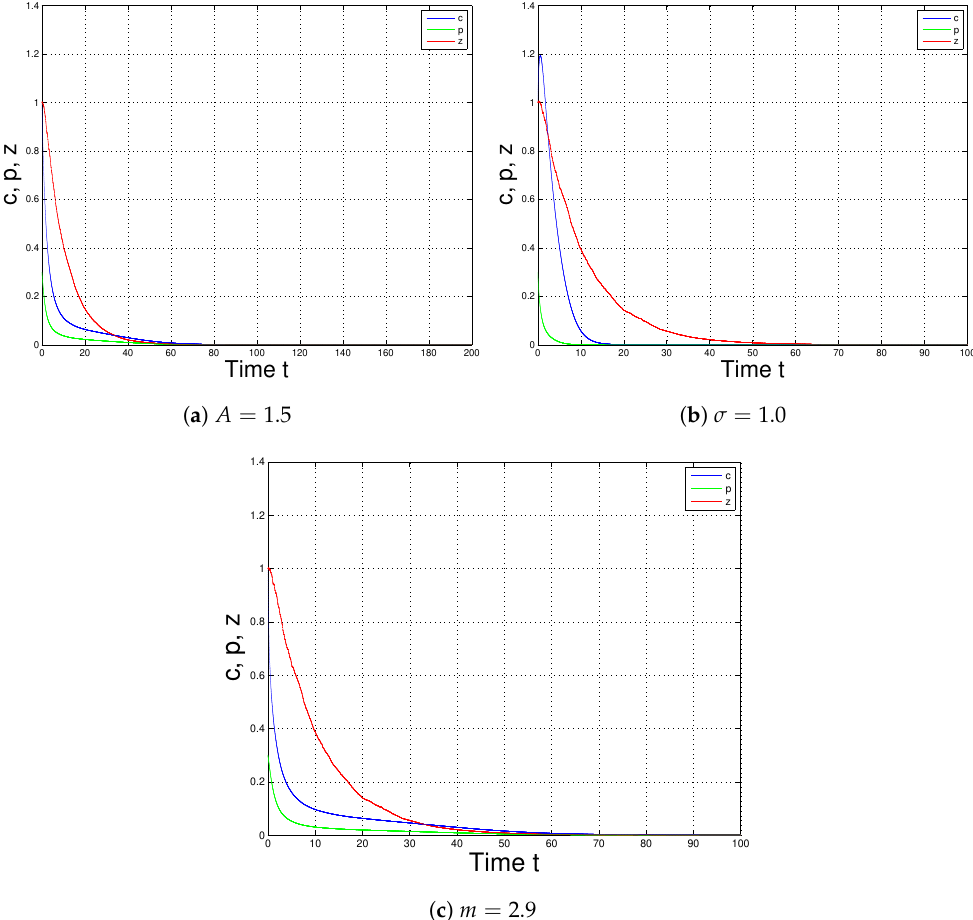
Figure 23. Depletion of oxygen and extinction of plankton corresponding to system (12) when ( a ) A = 1.5, ( b ) σ = 1.0, ( c ) m = 2.9 and the remaining parameters are chosen from set